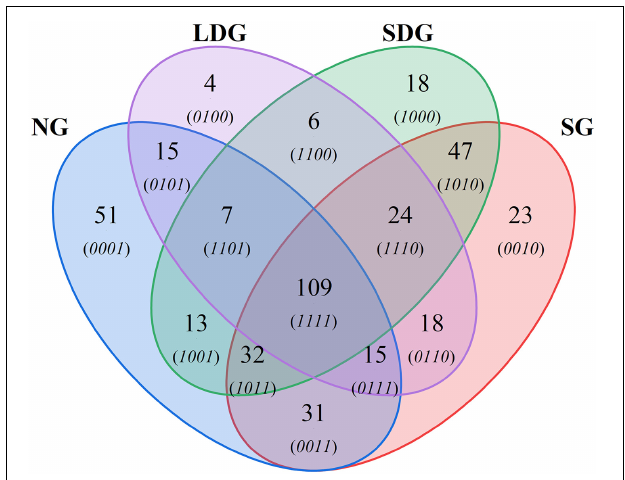
FIGURE 4 | Quantitative analysis of operational taxonomic units (OTUs) species in different grassland types. NG (blue), natural grassland; SG (red), sown grassland; LDG (purple), lightly degraded grassland; SDG (green), severely degraded grassland.